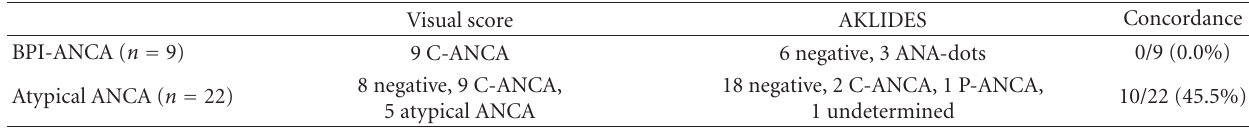
Table 2: ANCA pattern recognition in sera containing BPI-ANCA or atypical